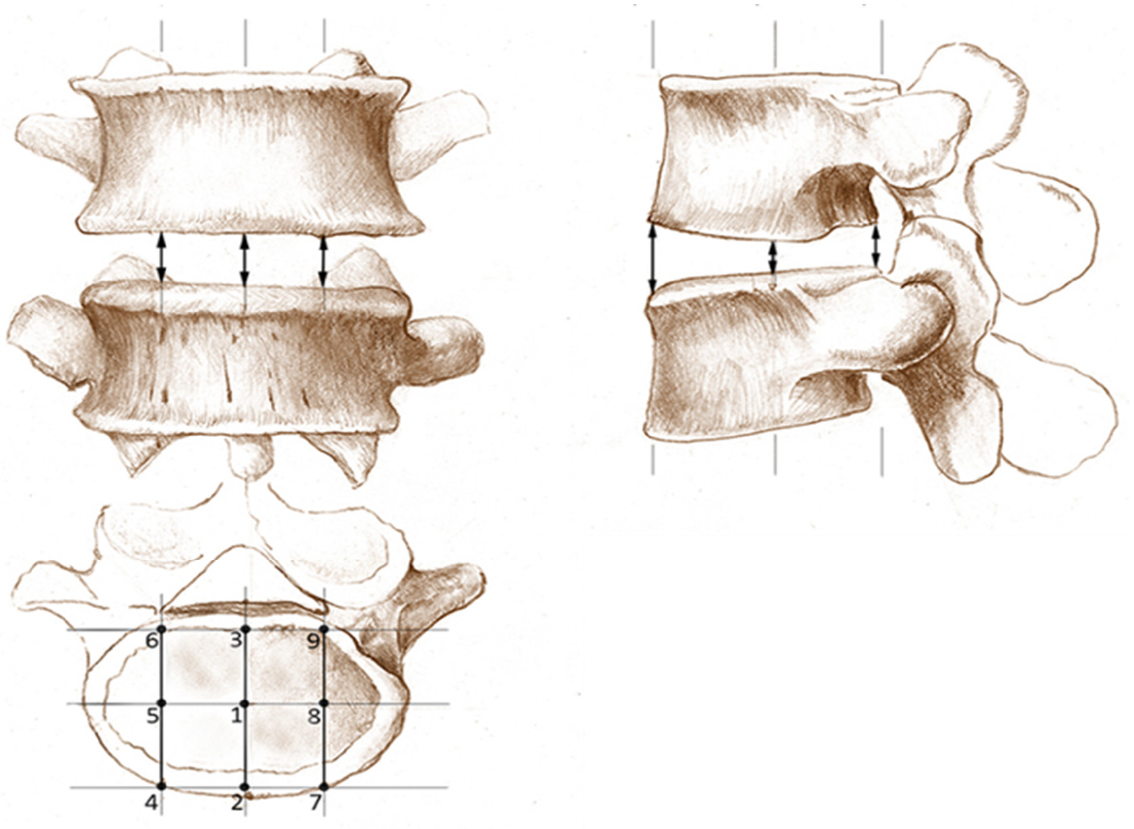
Figure 2. Schematic depiction of the height measurement method using the 9-point method H3. Mean heights are calculated as an arithmetic mean of the heights 1 to 9. Height H1 is measured at point 1 and height H2 is the arithmetic mean value of the points 2 and 3.